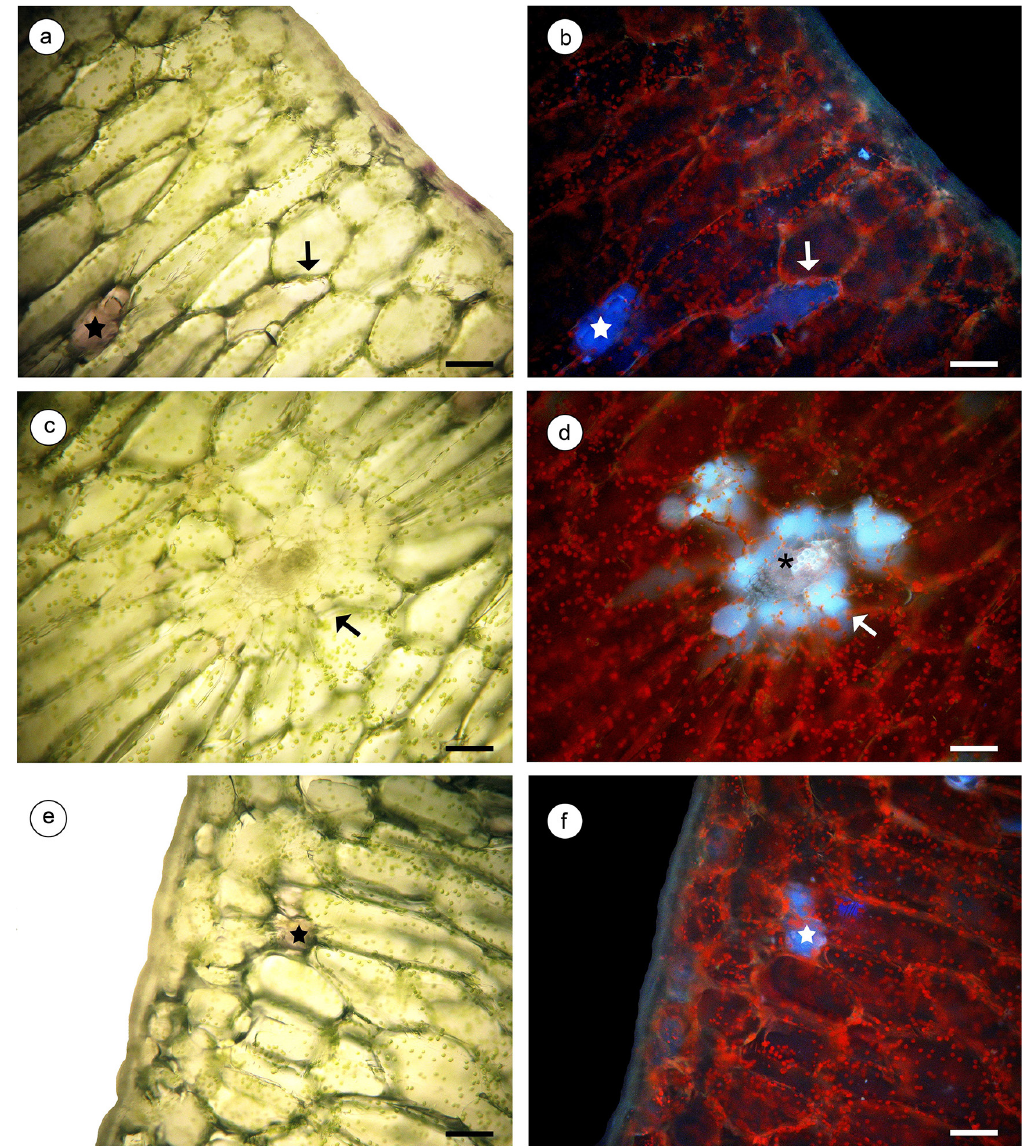
Fig. 4: Cross sections of Kalanchoe fedtschenkoi leaf blade at the middle third (control): adaxial side (a, b); main vascular bundle (c, d); abaxial side (e, f); visible light (a, c, e); UV light (b, d, f); anthocyanic idioblasts with pink color under white light and with blue fluorescence under UV (stars); blue fluo - rescent cells (arrows); vessel elements fluorescent in light blue (asterisk). Bars 100